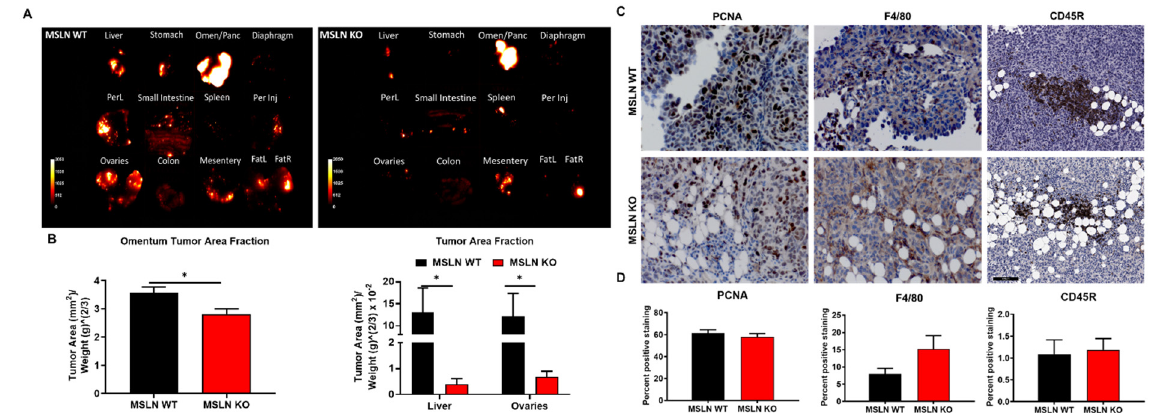
Figure 6. Organ-specific tumor burden. ( A ) Individual organs were dissected and imaged. ( B ) Tumor burden was quantified with ImageJ. Among all abdominal organs, the omentum, liver and ovaries from MSLN KO mice had significantly less tumor burden than MSLN WT mice. * p < 0.05; error bars represent standard error of mean. ( C ) Immunohistochemical analysis of omental tumor tissues. Omental tumor tissue IHC analysis of proliferation (PCNA), macrophages (F4/80), and tumor infiltrating lymphocytes (CD45R). Representative images of MSLN WT and MSLN KO omental metastases are shown. Scale bar = 100 µ m. ( D ) Quantitation of positive staining. Analysis was carried out with the Aperio Image Analysis Tools package. Error bars represent standard error of mean. Omen/panc = Omentum/Pancreas, PerL = Parietal Peritoneum Left, Per Inj = Parietal Peritoneum Injection Side, Ovaries = Ovaries/Uterus and Periovarian Adipose Tissue, FatL = Visceral adipose tissue from left of uterus, FatR = Visceral adipose tissue from right of